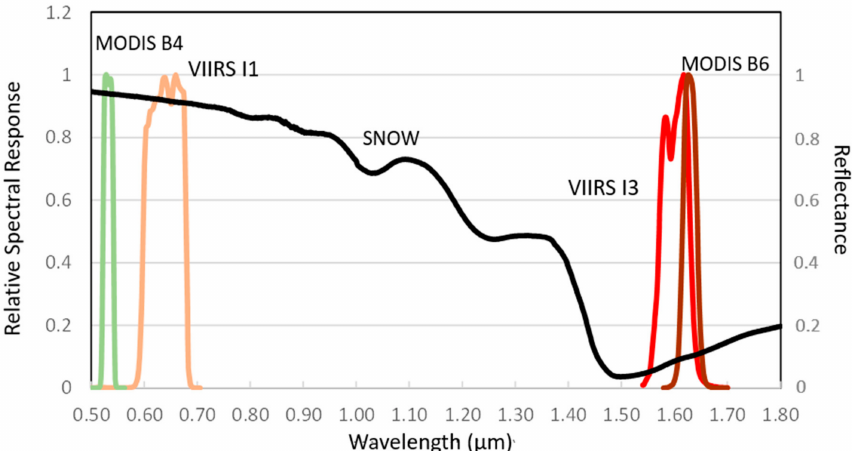
Figure 1. MODIS and VIIRS band locations compared to a spectral reflectance curve for fresh snow. The plots of relative spectral response for MODIS and VIIRS bands were created using data from [30,31] respectively. The spectral reflectance curve for snow was derived from an average of field spectral reflectance data collected at the same site with similar environmental conditions on 17, 18 and 22 March 2010 as described in the text and available from [32].